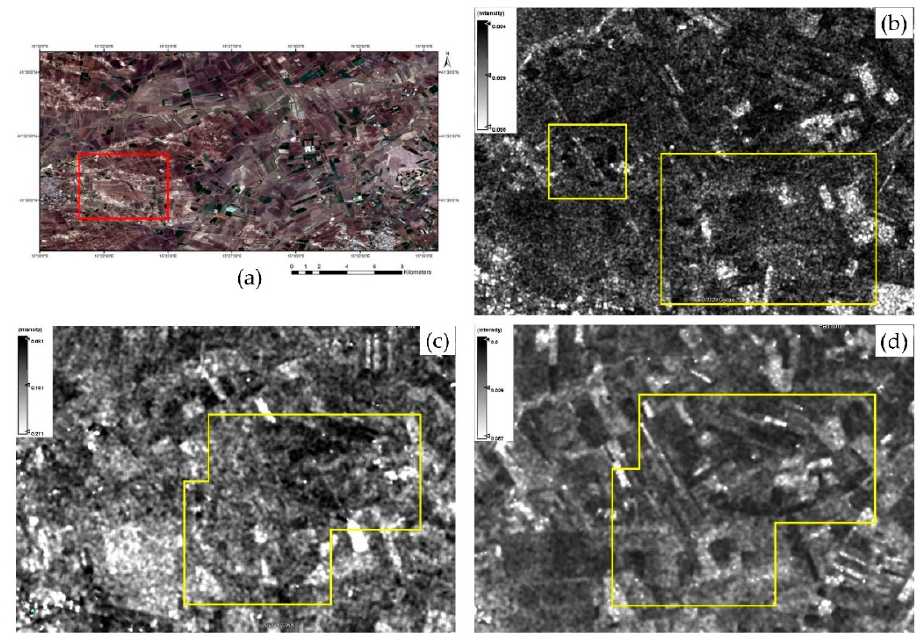
Figure 7. Known archaeological sites identifiable within the S-1 SAR data: ( a ) location of the zoom area east of Lucera (S-2, RGB, 20 October, 2019); ( b ) Masseria Sarcone and Masseria Albani (S-1, 19 October, 2019, Sigma_0 VH); ( c ) Masseria Villano (S-1, 28 October, 2016, Sigma_0 VH); ( d ) Masseria Villano and Masseria Seggese (S-1, 28 October, 2016, Sigma_0 VV) [65].